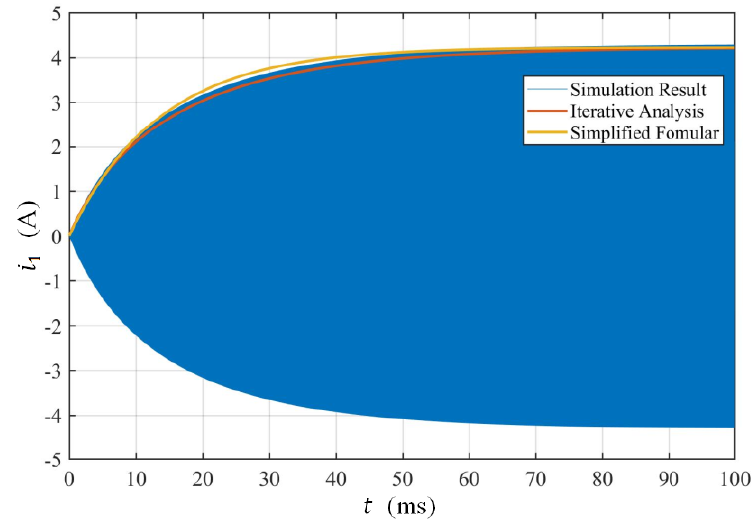
Figure 7. Comparison of simulation curve of mechanical branch current with iterative analysis and simplified formula.